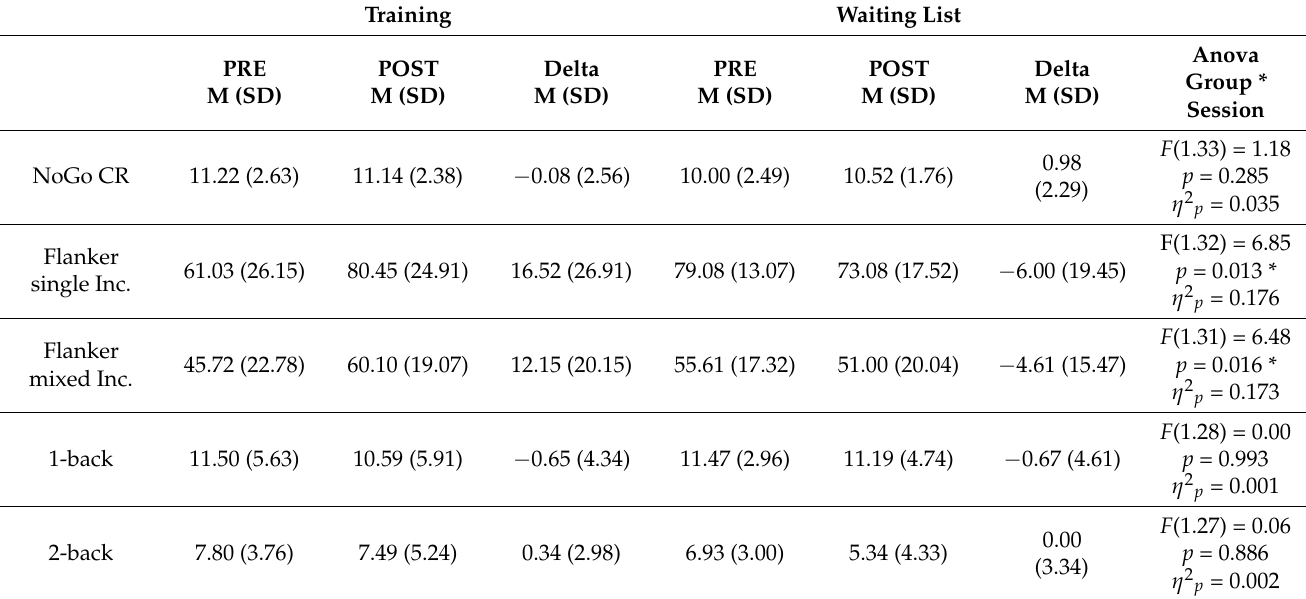
Table 4. Executive functions’ performance at pre- and post-test of children with SLD in the training and waiting list conditions and results of ANOVA comparing ∆